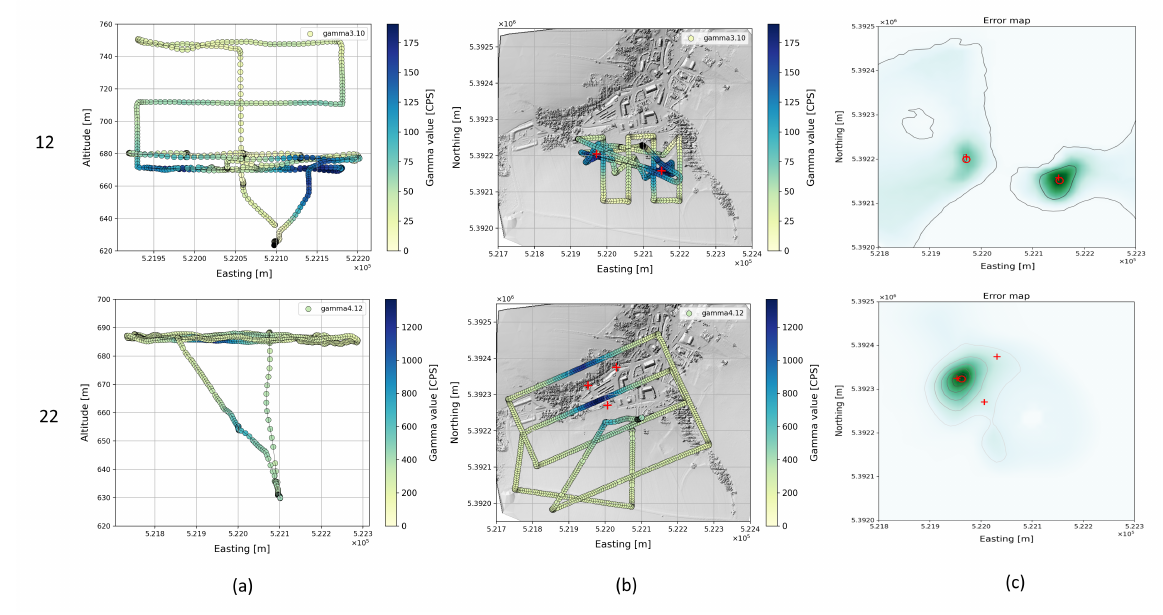
Figure 9. Flight pattern for selected flights (12, 22) with multiple radioactive sources projected to xz-plane ( a ) and projected to ground xy-plane ( b ). The gamma measurements are color-coded. The corresponding cost map is shown in ( c ).